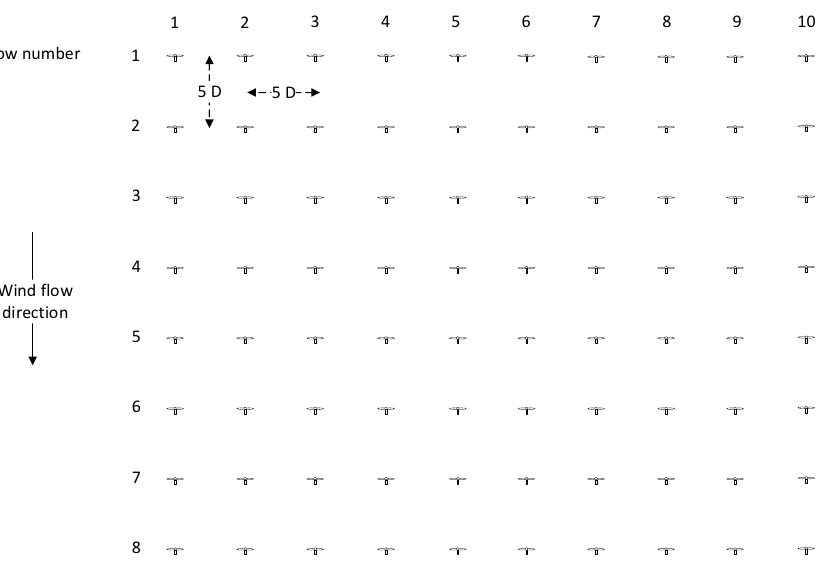
Figure 9. Layout of large-scale wind farm used for the testing of